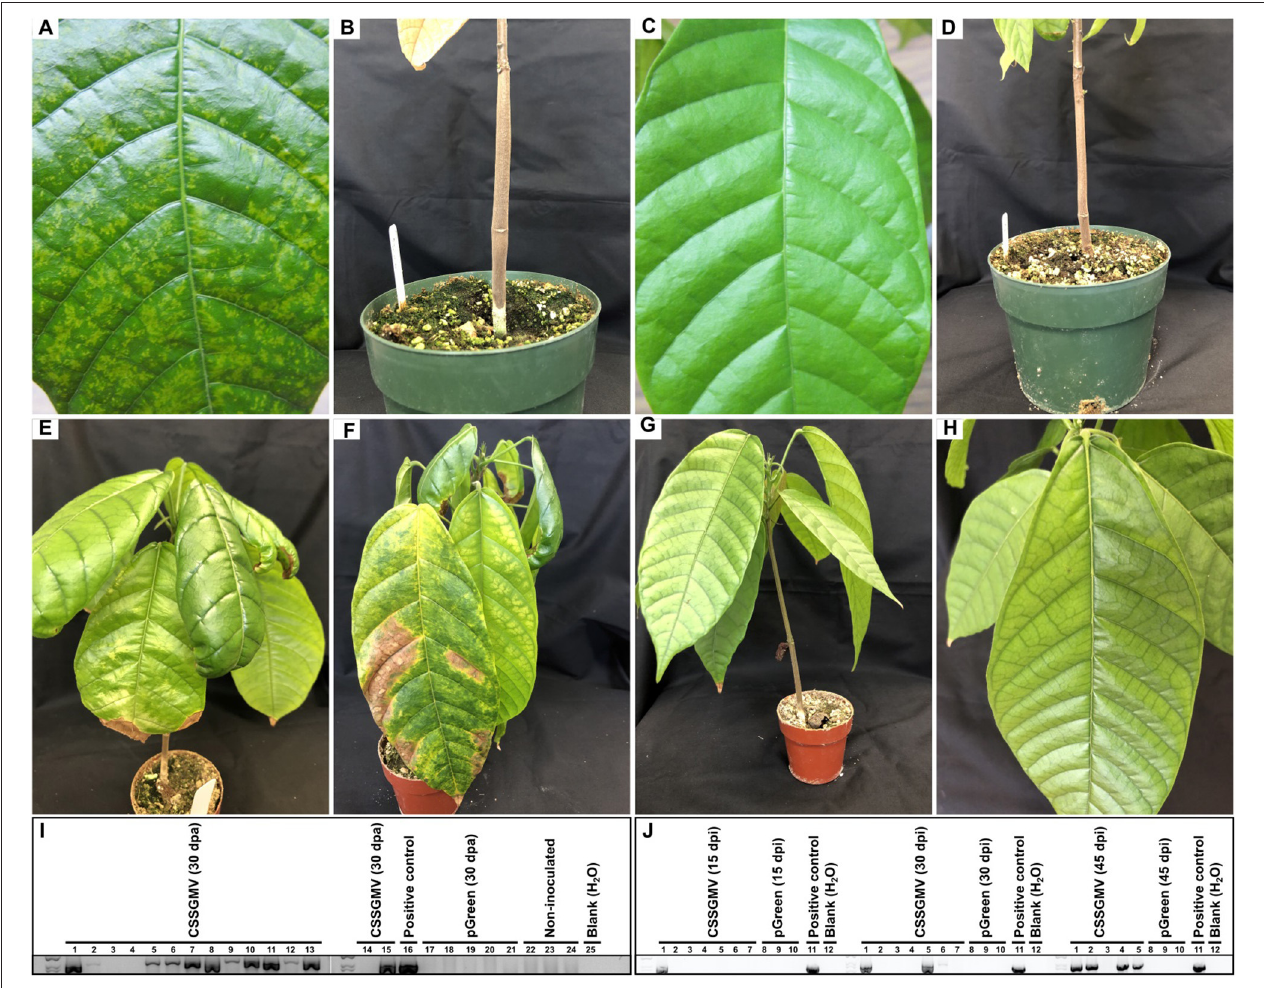
FIGURE 2 | Infectivity assay of the cacao swollen shoot Ghana M virus (CSSGMV) infectious clone in cacao ‘Amelonado’ seedlings. Agroinoculated plants displaying yellow chlorotic mottling (A) and shoot swelling (B) symptoms. No symptoms were observed in mock control plants (C,D) . PCR detection of CSSGMV was performed, at 30 days-post-agroinoculation (dpa), using species-specific primers, and expected size amplicons were observed from 12 of 15 agroinoculated plants (lanes 1–15); no amplification fragment was observed from control plants (lanes 17–24) (I) . Biolistic-inoculated plants exhibiting symptoms of interveinal chlorosis and necrotic crinkling (E) , and interveinal chlorosis, necrotic crinkling, chlorotic mottling, and necrosis spreading from primary veins (F) . Symptomless mock control plants (G,H) . PCR detection of CSSGMV was performed, at 15, 30, and 45 days-post-inoculation (dpi), using species-specific primers. Expected size amplicons were observed from 1 of 7, 3 of 7, and 4 of 5 plants (lanes 1-7) at 15, 30, and 45 dpi, respectively; no amplification fragment was obtained from mock treatments (lanes 8-10) (J) . The partial nucleotide sequences of the cloned amplicons shared 99.9-100% identity with CSSGMV-Nig9.